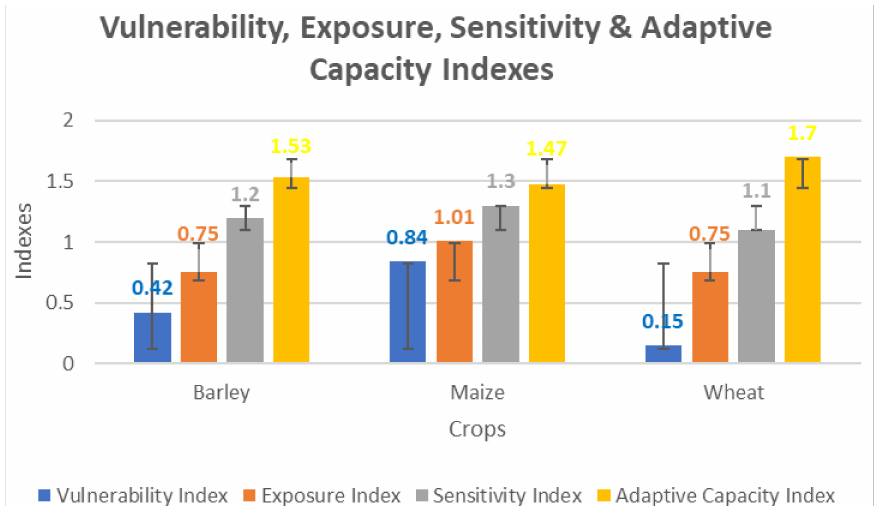
Figure 6. Vulnerability, exposure, sensitivity, and adaptive capacity indexes of selected crops in Morocco.